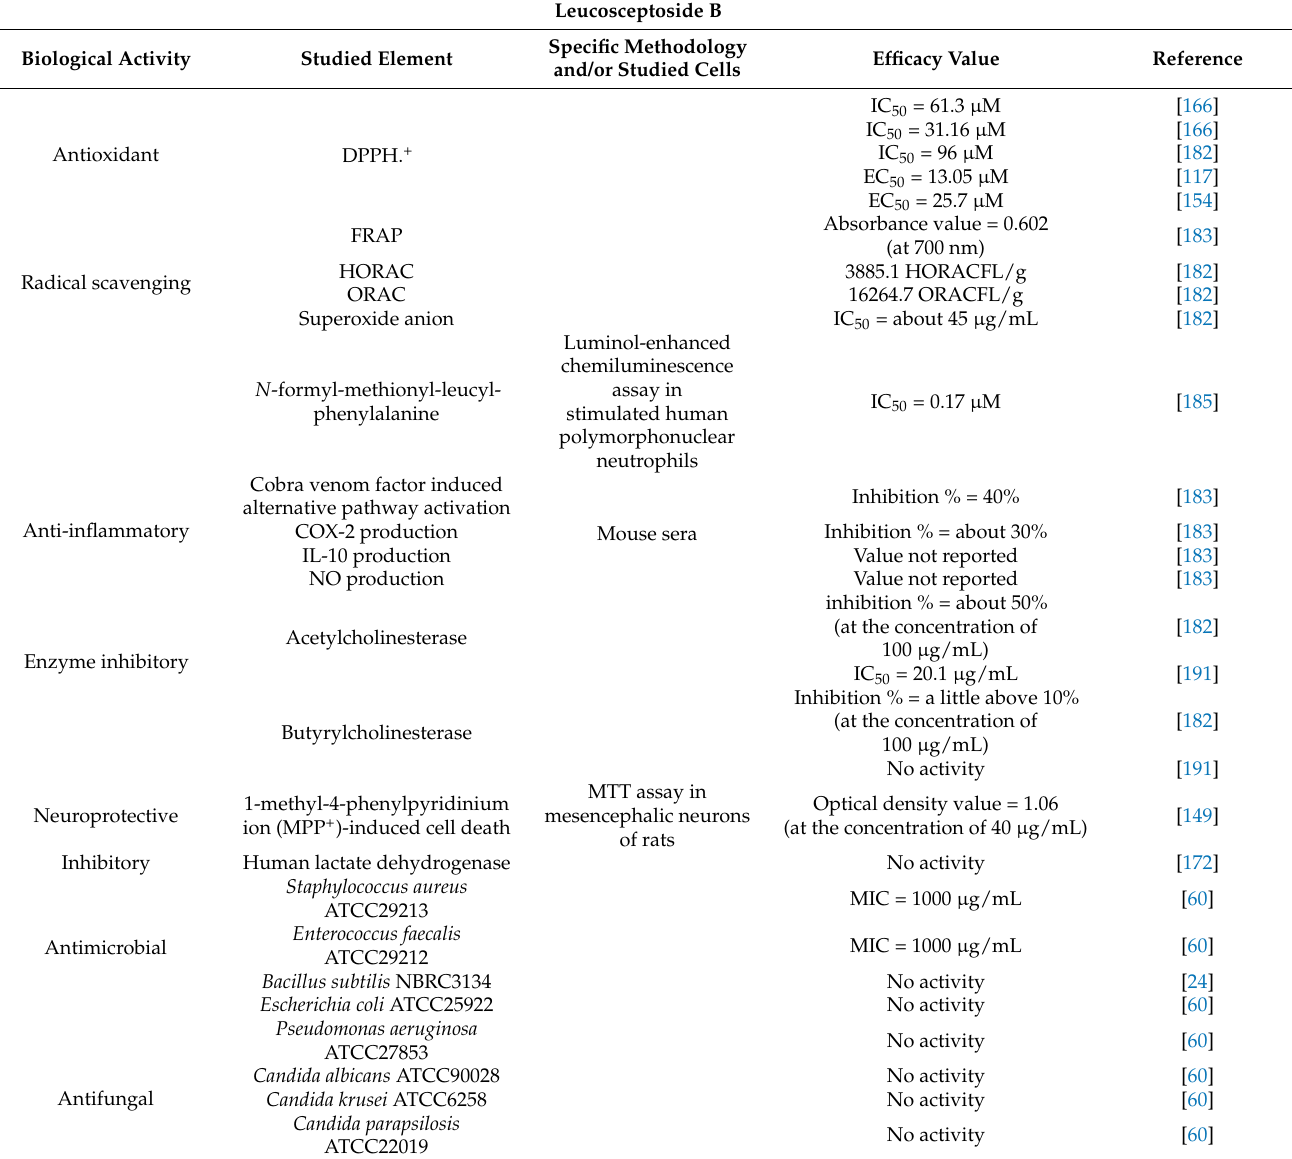
Table 4. Summary of the biological activities and efficacy values of leucosceptoside B. Leucosceptoside